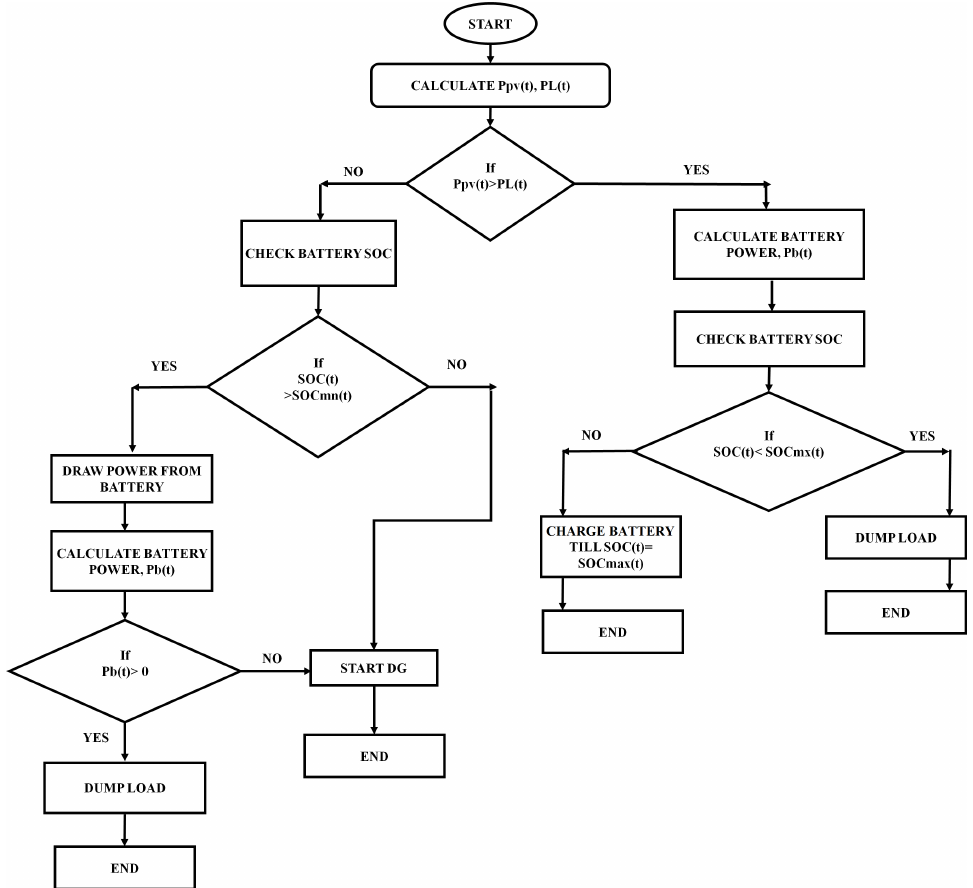
Figure 4. Flowchart for working of the proposed hybrid microgrid